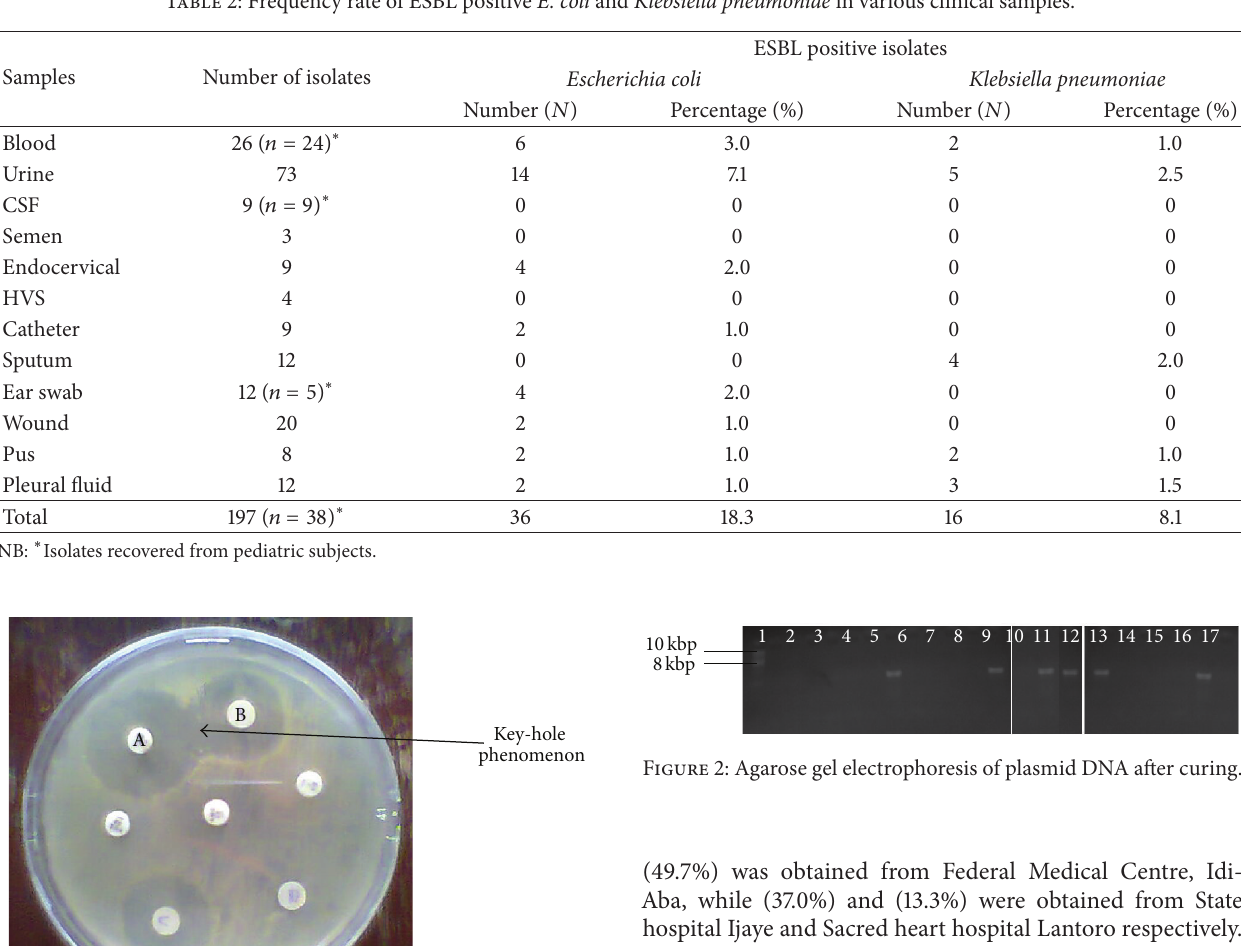
(Table 2), Escherichia coli having 61 (45.2%) and Klebsiella